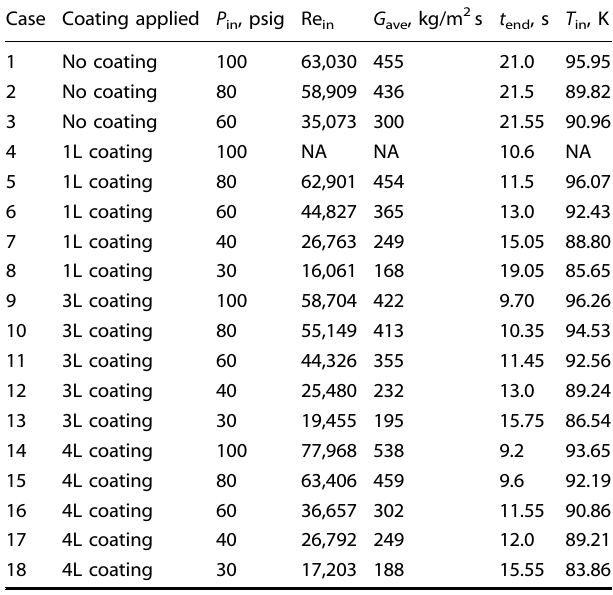
Table 2. Test conditions for the 18 tests, representing low fl ow rate, medium fl ow rate, and high fl ow rate